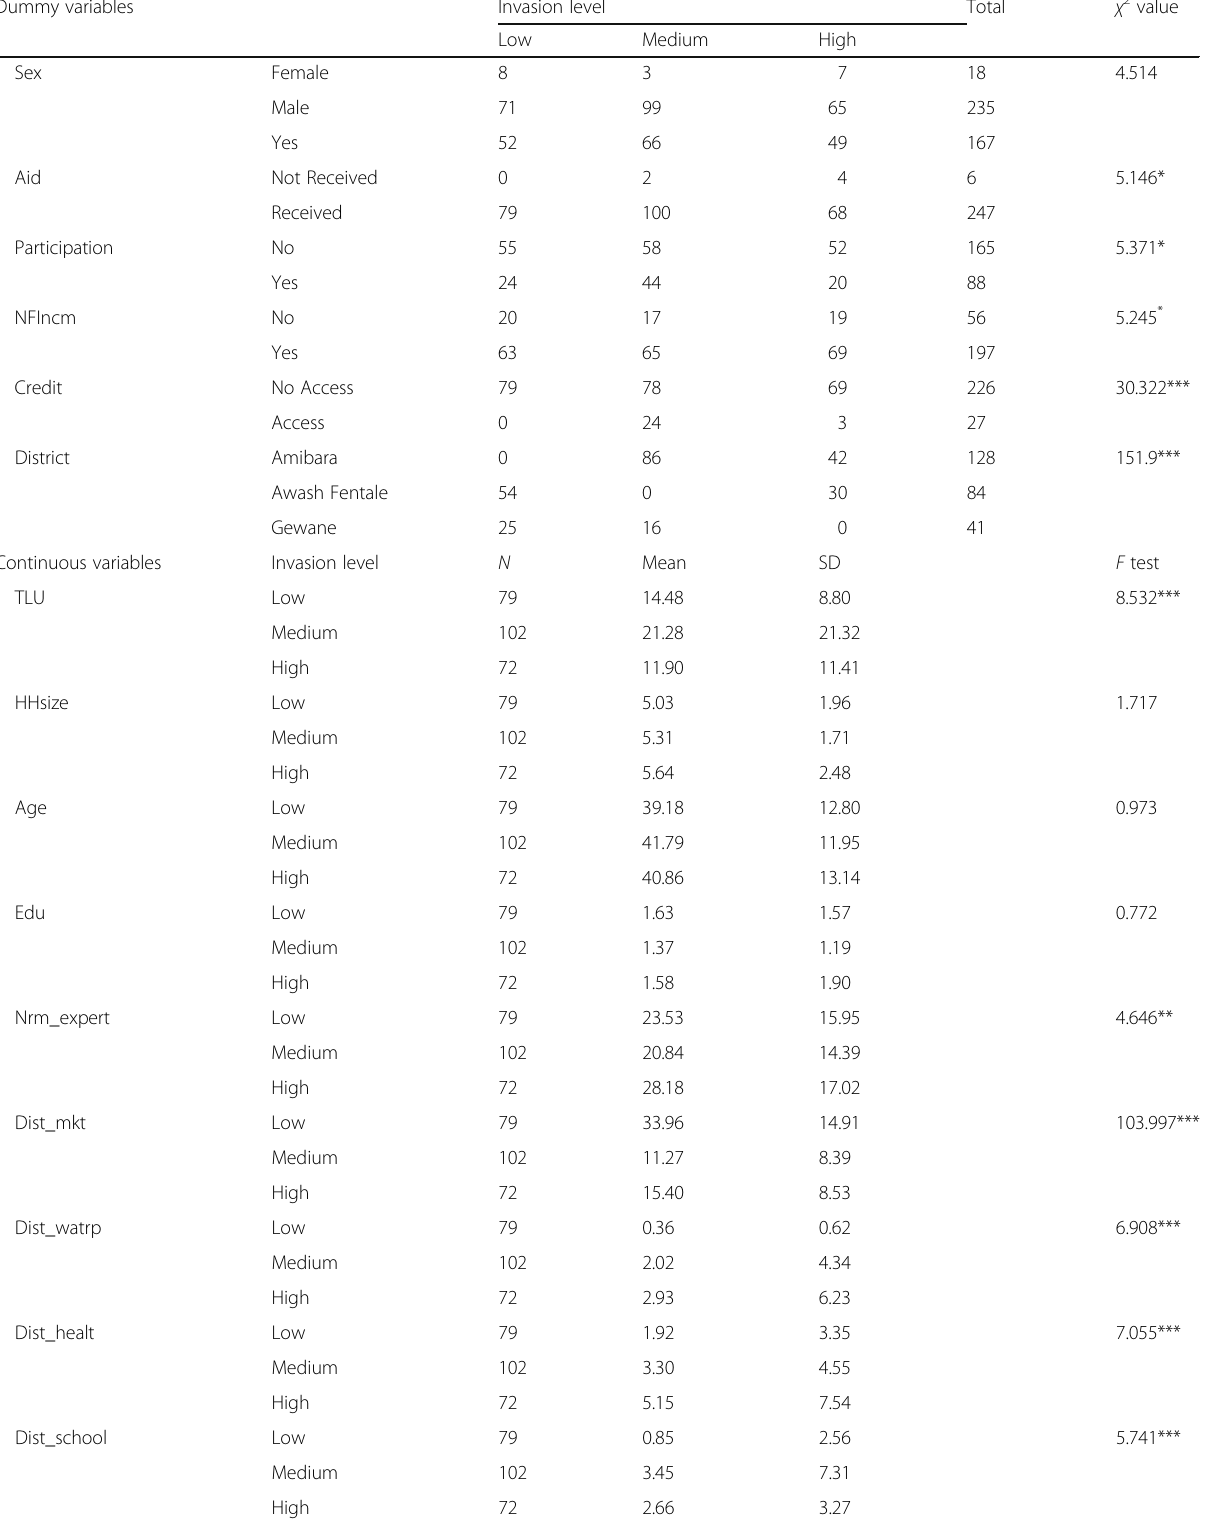
Table 4 Scio-economic characteristics of sample households by invasion level Dummy